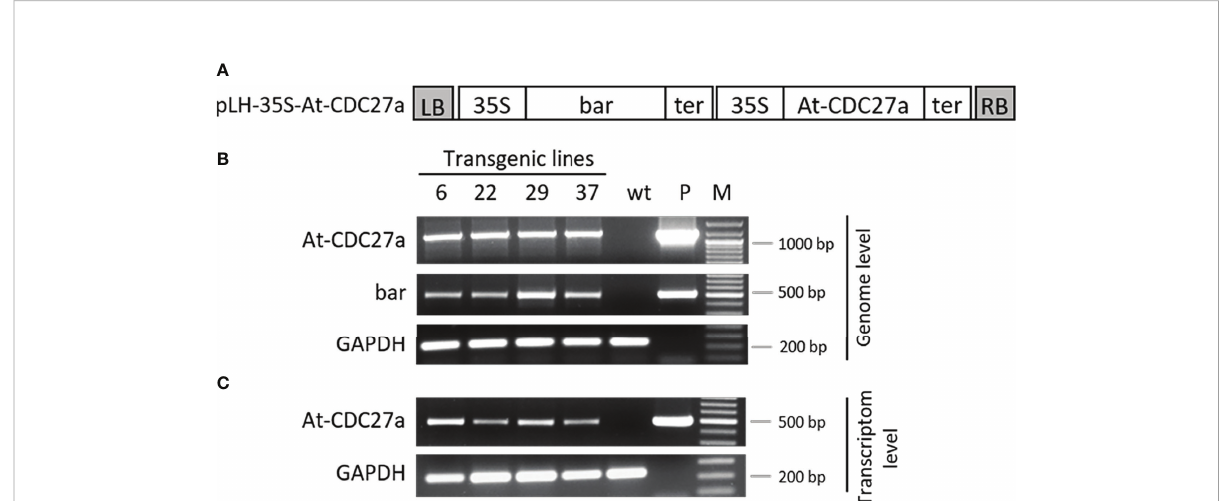
FIGURE 1 Molecular veri fi cation of the At-CDC27a transgenic lines. (A) Schematic diagram of the pLH- 35S-CDC27a transformation vector. The pLH- 35S- CDC27a binary vector contains the bar and At-CDC27a genes. Both genes are controlled by the CaMV 35S promoter and the appropriate terminator. The open boxes indicate the following sequences: bar, bar gene; At-CDC27a, At-CDC27a gene; 35S, 35S promoter; ter, terminator; LB, RB, left and right border of T-DNA, respectively. (B) PCR analysis of the At-CDC27a transgenic lines. Genomic DNA was isolated from the At-CDC27a-6, At-CDC27a-22, At-CDC27a-29 and At-CDC27a-37 transgenes and subjected to PCR analysis using the At-CDC27a, bar and GAPDH speci fi c primers. Plasmid pLH- 35S-CDC27a and genomic DNA from non-transgenic N. benthamiana served as positive and negative controls, respectively. (C) Expression analysis of the At-CDC27a transgenic lines. Total RNA extracted from the At-CDC27a-6, At-CDC27a-22, At-CDC27a-29 and At-CDC27a-37 transgenes were investigated by RT-PCR using speci fi c primers for the At-CDC27a and GAPDH . Wild type N. benthamiana cDNA served as a negative control and the pLH- 35S-At-CDC27a plasmid DNA served as a positive control. GeneRuler 100 bp Plus DNA marker (Thermo Scienti fi c, Waltman, United States